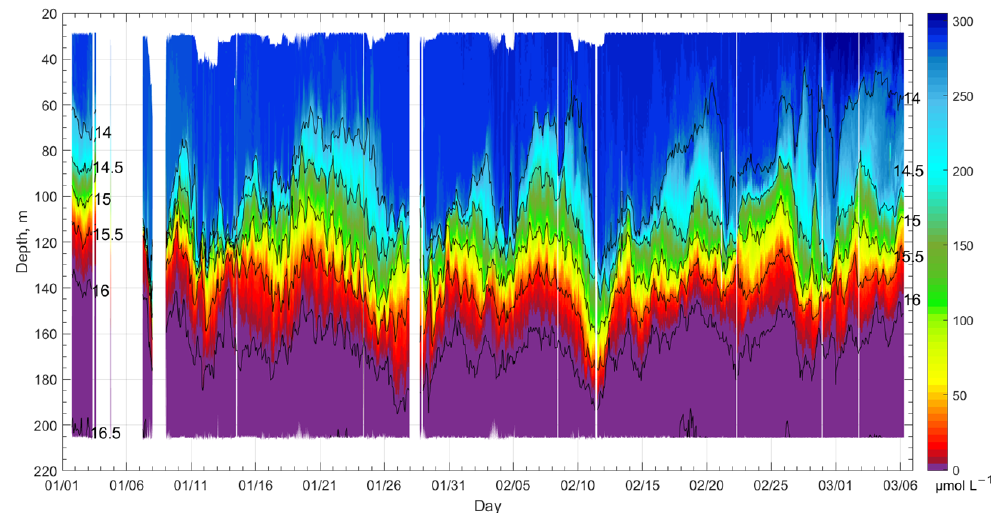
Figure 4. Temporal evolution of the dissolved oxygen vertical distribution. The measurements were obtained using an SBE 43F sensor housed in an Aqualog moored profiler in the NE Black Sea (see Fig. 1 for location). The black lines indicate isopycnals σ (cid:50)